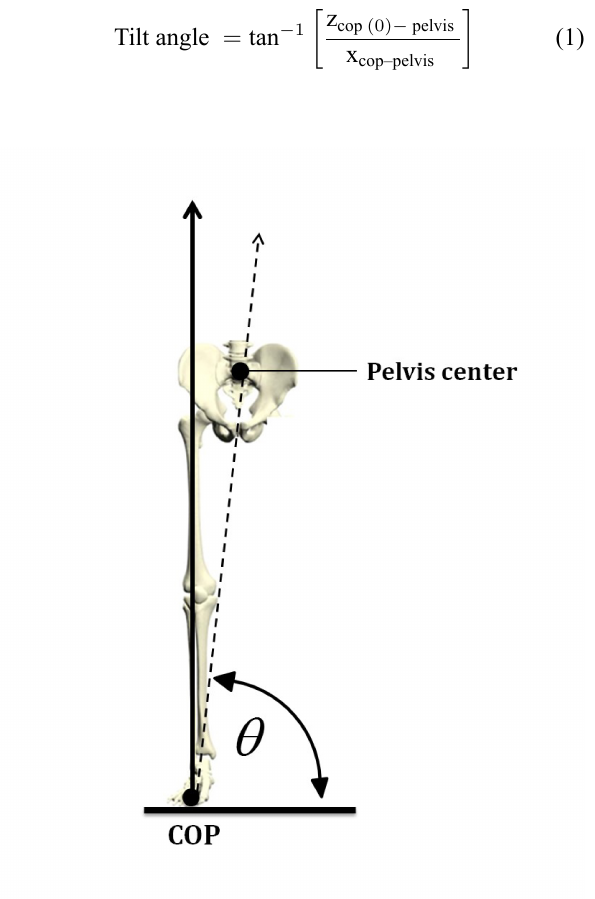
Fig. 2. Tilt angle between pelvis center and center of pressure